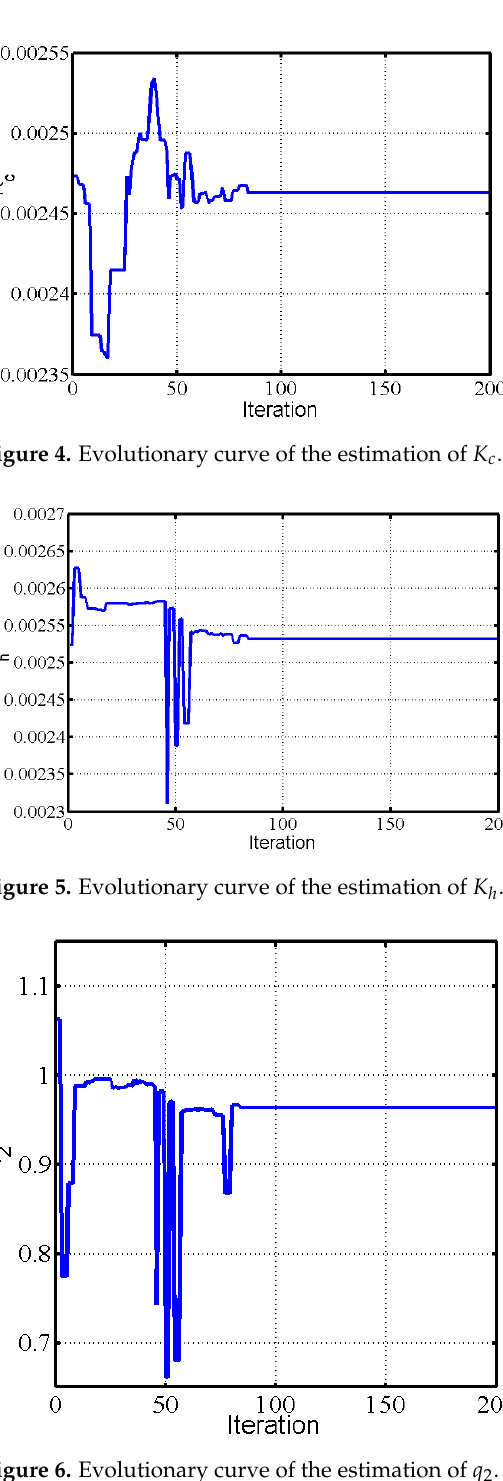
Figure 6. Evolutionary curve of the estimation of q 2